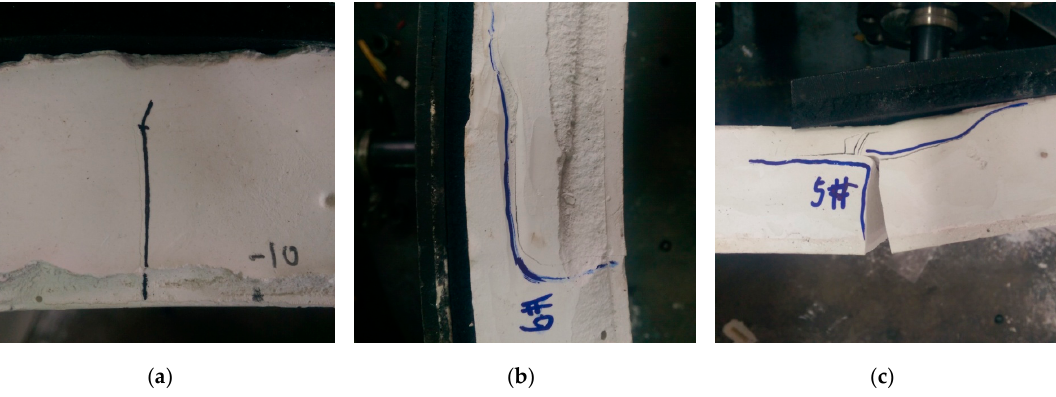
Figure 21. Crack types in the direction of the lining thickness. ( a ) I ‐ type crack (15.4%), ( b ) L ‐ type crack (69.2%), and (c) Y ‐ type crack (15.4%).